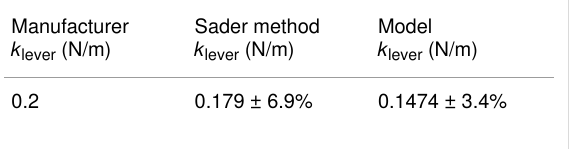
Table 2: Modeled values of k lever . A BudgetSensors diamond-coated silicon cantilever with 450 μ m length and a spring constant of 0.2 N/m was used in this experiment.